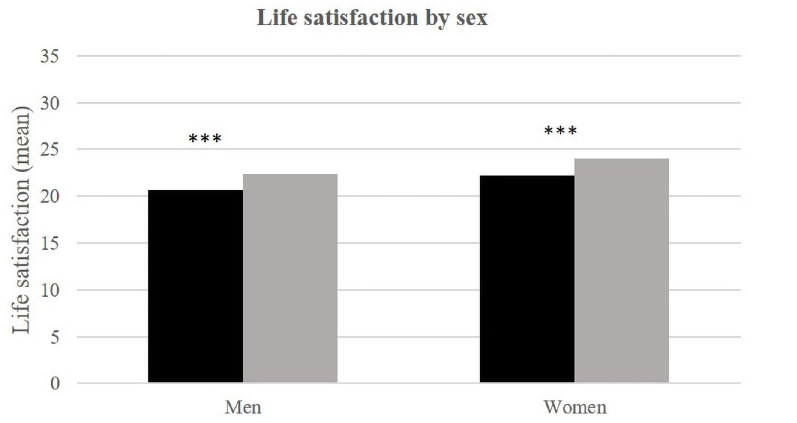
Fig 2. Life satisfaction (mean) by sex and place of life.